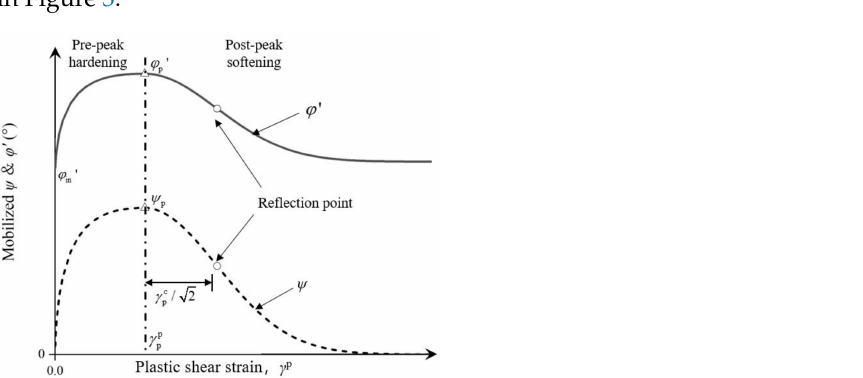
Figure 3. Typical curves of modified friction angle and modified dilation angle with plastic shear strain (after Roy et al.